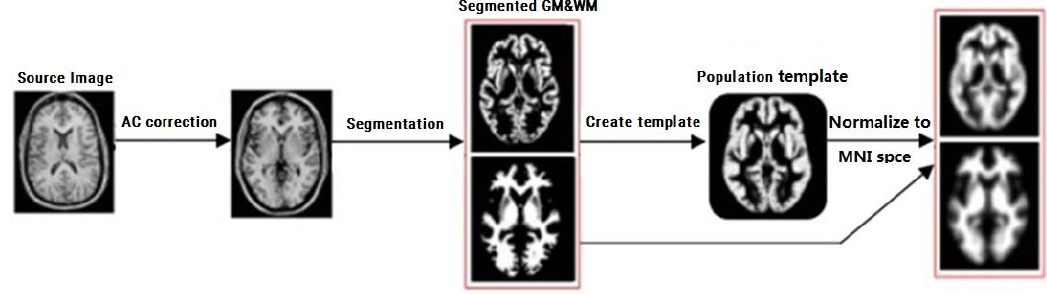
Figure 1. The procedure of the Diffeomorphic Anatomical Registration through Exponential Lie Algebra.